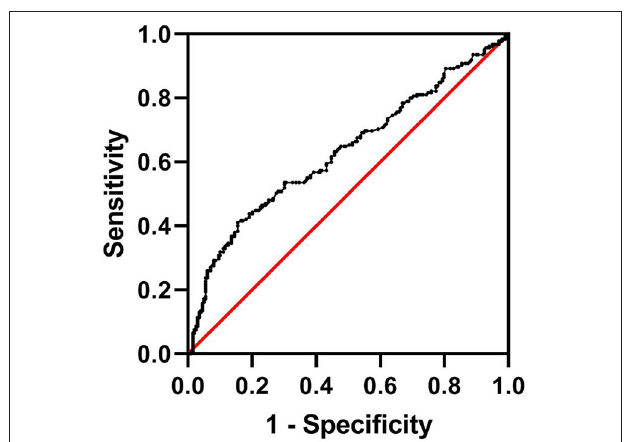
FIGURE 1 | Determination of the cutoff value for the FIB-4 score in AIS patients undergoing HT by ROC analysis. AIS, acute ischemic stroke; HT, hemorrhagic transformation; FIB-4, Fibrosis-4 score; ROC, receiver operating